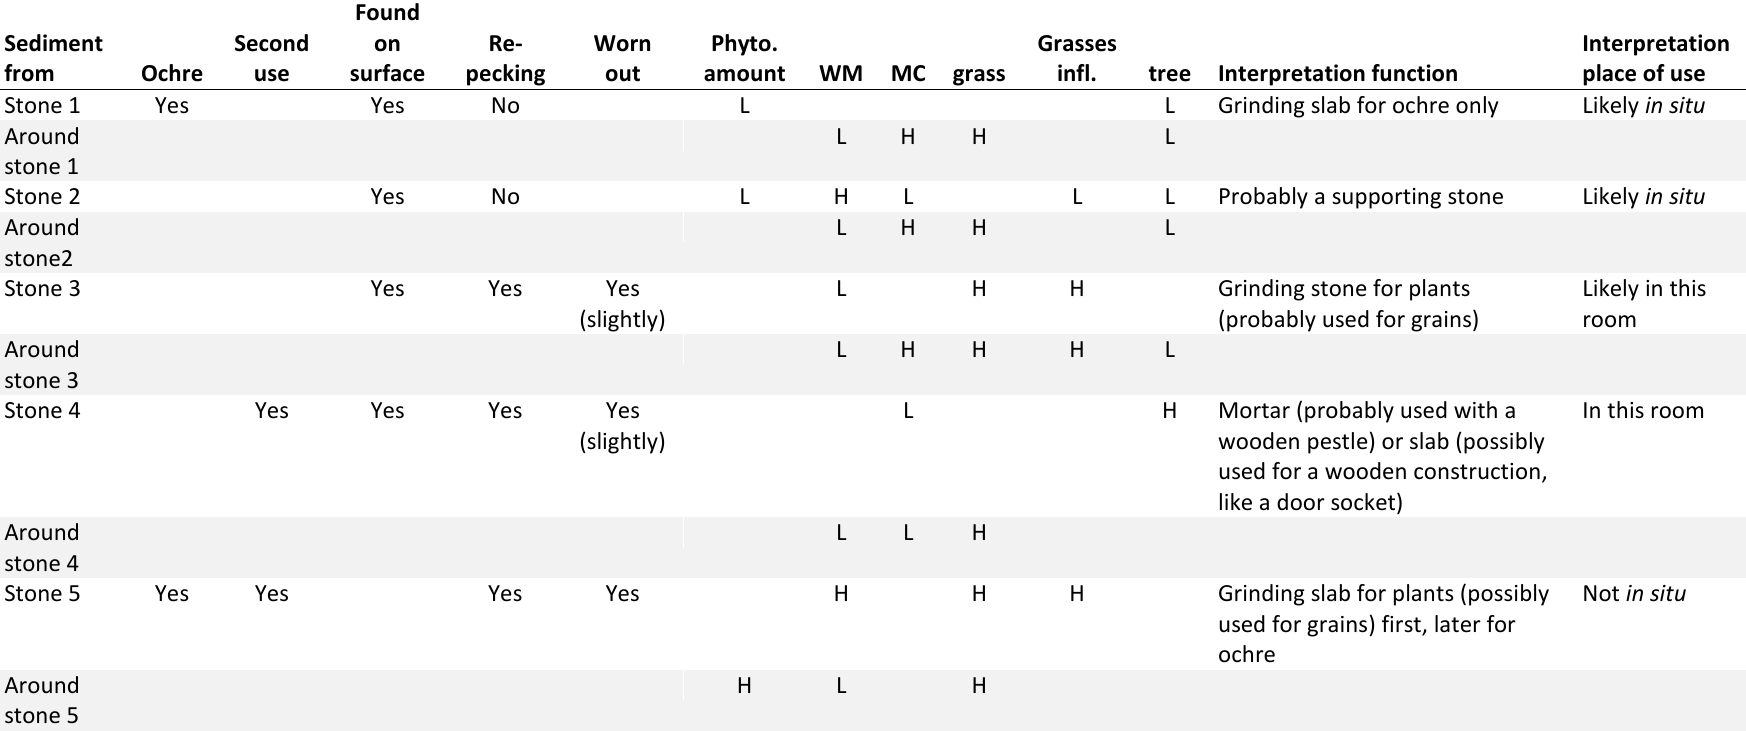
Table 3: Summary of the main results of the archaeological and phytolith analyses Only those values that stand out as especially high or low are indicated in the table. Abbreviations: phyto. - phytoliths; WM - weathered morphotypes; MC - multicells; infl. - inflorescence; L - low; H -